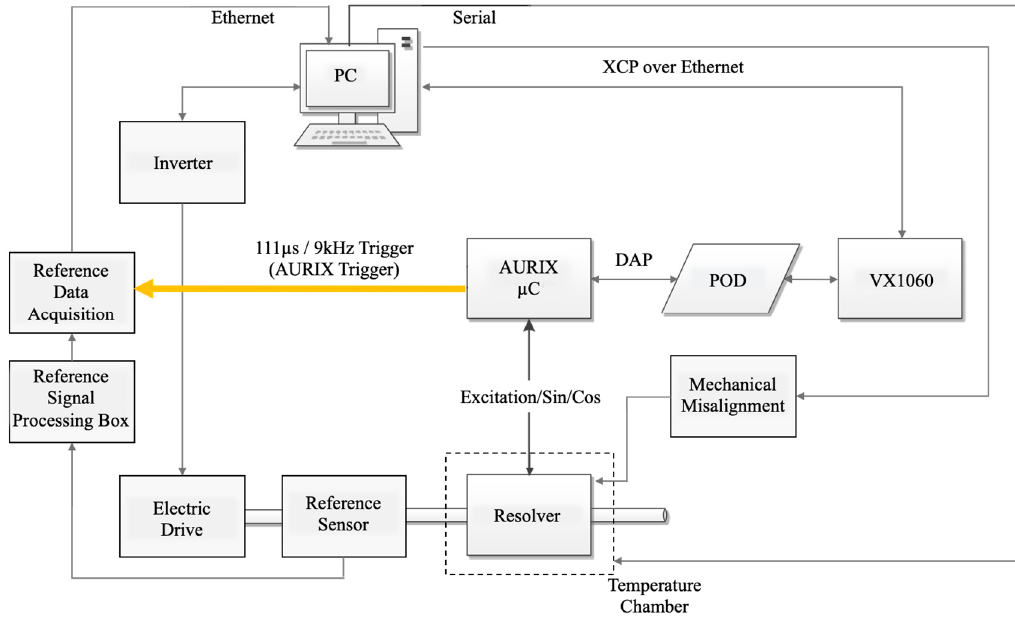
Figure 10. Detailed overview of the test setup including the electrical synchronization trigger.